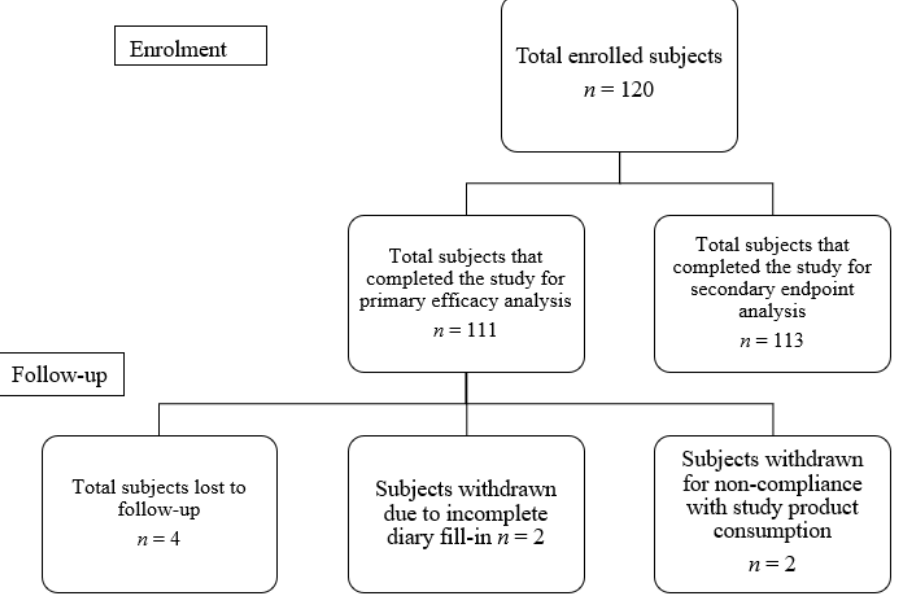
Figure 1. Participant disposition.